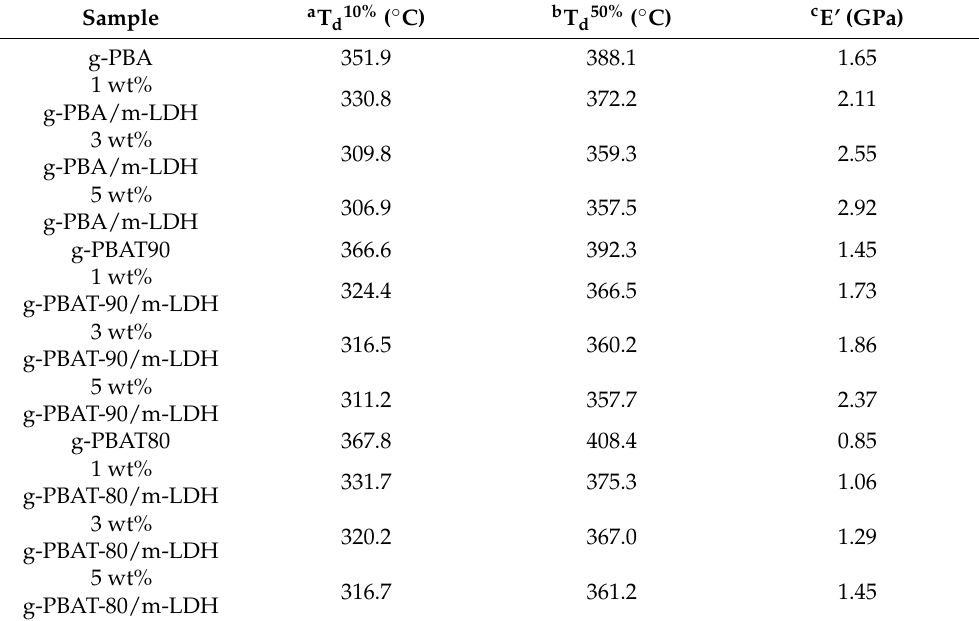
Table 2. Thermal degradation temperatures at 10% and 50% weight losses and storage modulus in bending mode, at − 90 ◦ C, of the various g-PBAT/m-LDH nanocomposites.